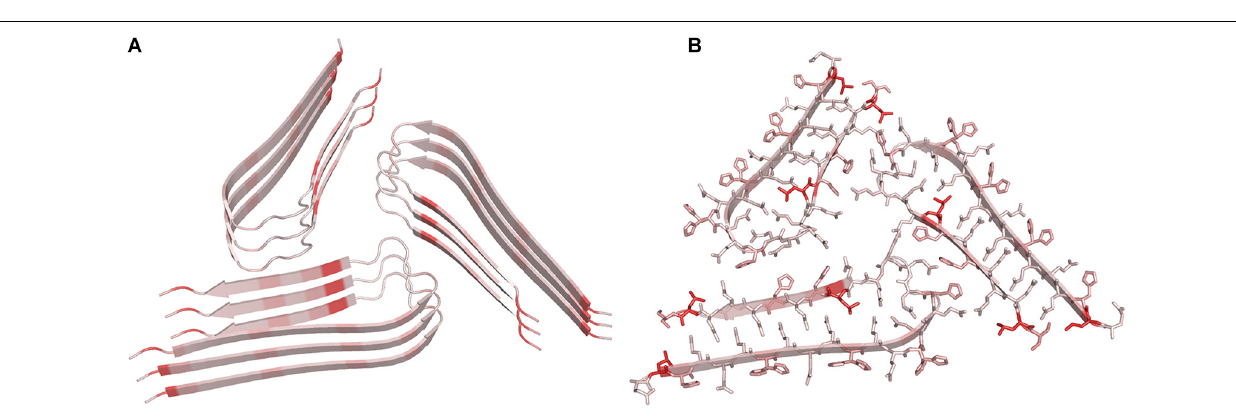
FIGURE 5 | Ribbon (A) and ball and stick representation (B) structure of the hydrophilic core of cross-beta Orb2 filaments (PDB code 6vps) Residues are colored as function of their hydrophobicity from gray (polar) to red